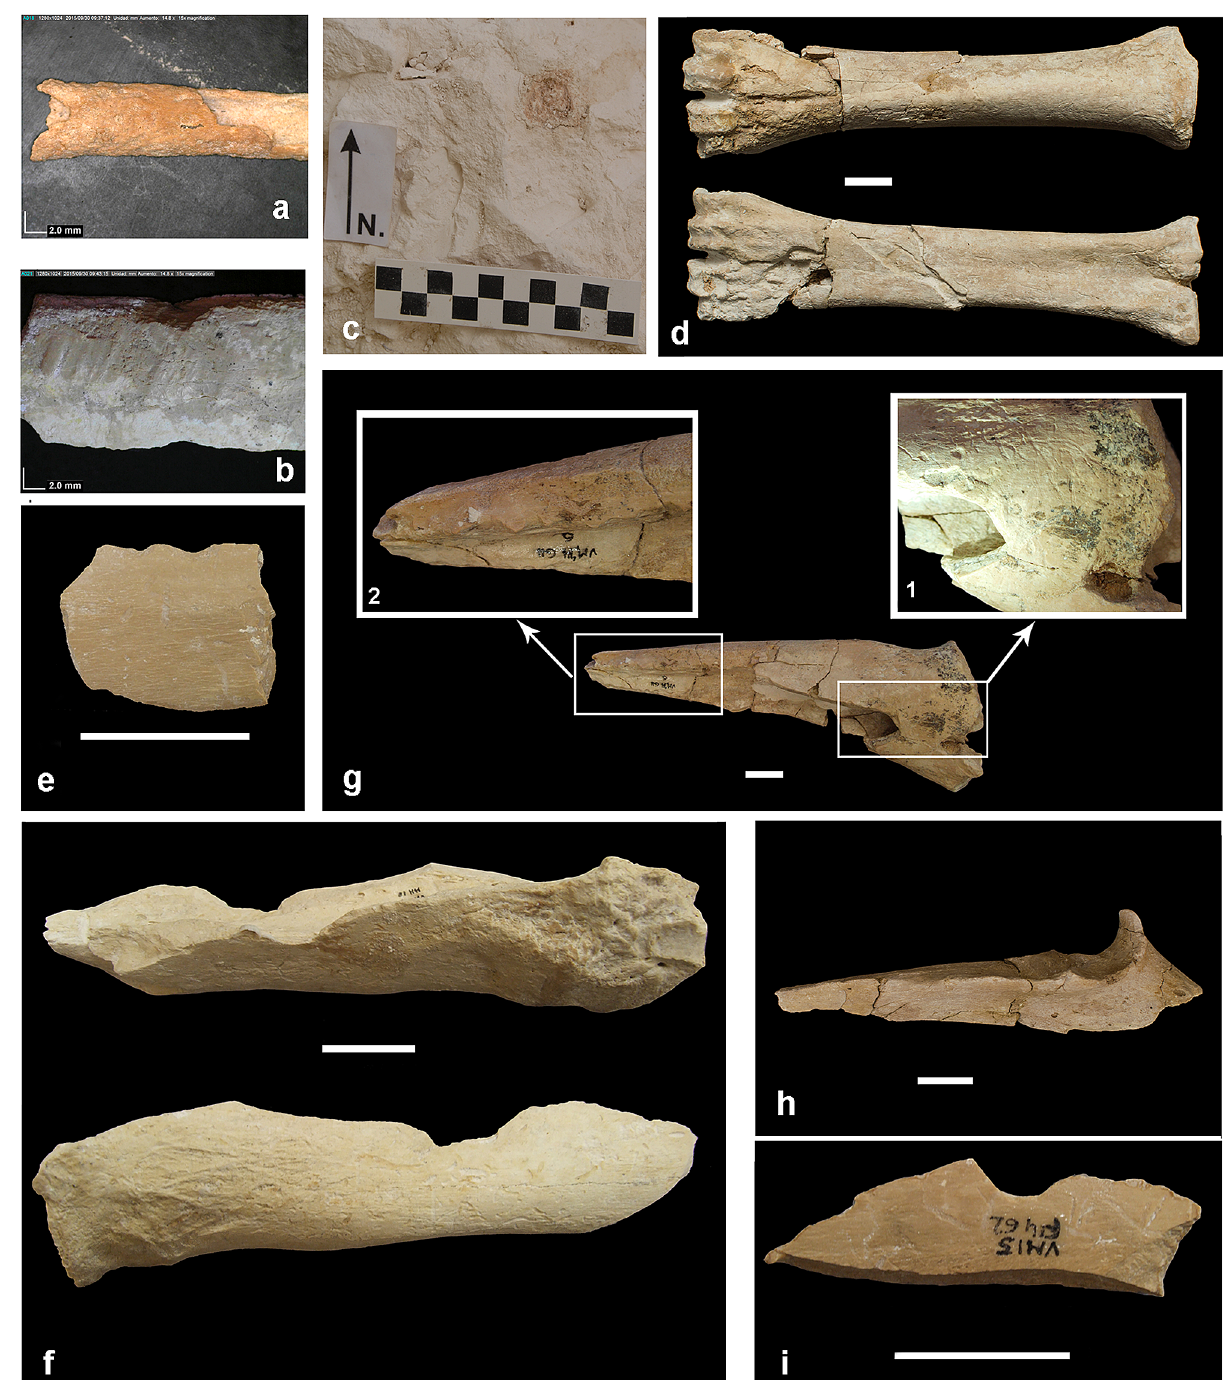
Figure 5. Examples of bone remains and a hyaena coprolite from the excavation quarry VM4 of Venta Micena. ( a ) Diaphysis of a digested long bone of bird. ( b ) Bone fragment showing gnaw marks made by a porcupine ( Hystrix sp.). ( c ) Coprolite of Pachycrocuta brevirostris. ( d ) Third-fourth metacarpal of a large Bovini showing a different degree of bone weathering in its proximal and distal part (this bone, preserved complete, shows some diagenetic fractures orthogonal to the major axis, which resulted from sediment compaction). ( e ) Bone flake with micronotches and tooth marks. ( f ) Fragment of a radius of a large-sized ungulate (the upper view shows the presence of a double opposing notch, the lower one shows one notch, pits, and scores). ( g ) Proximal radius of megacerine deer Praemegaceros cf. verticornis fragmented and consumed by the hyaenas [the enlarged photographs show pits (1) and crenulated edges (2)]. ( h ) Ulna of hippo Hippopotamus antiquus consumed by the hyaenas, showing several pits. ( i ) Notch on an indeterminate bone fragment. Scale bars in ( c - i ) represent 2